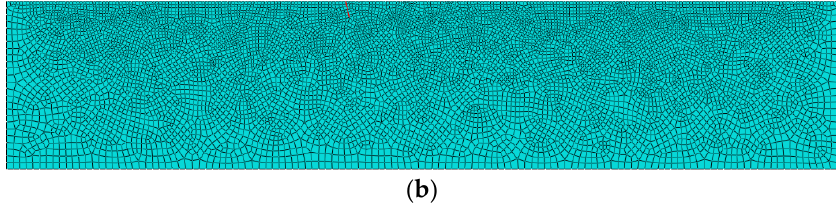
Figure 2. FEM model of the micro-crack zone: ( a ) distribution of micro-cracks; ( b ) finite element mesh (the red line represents one crack in the micro-crack zone).